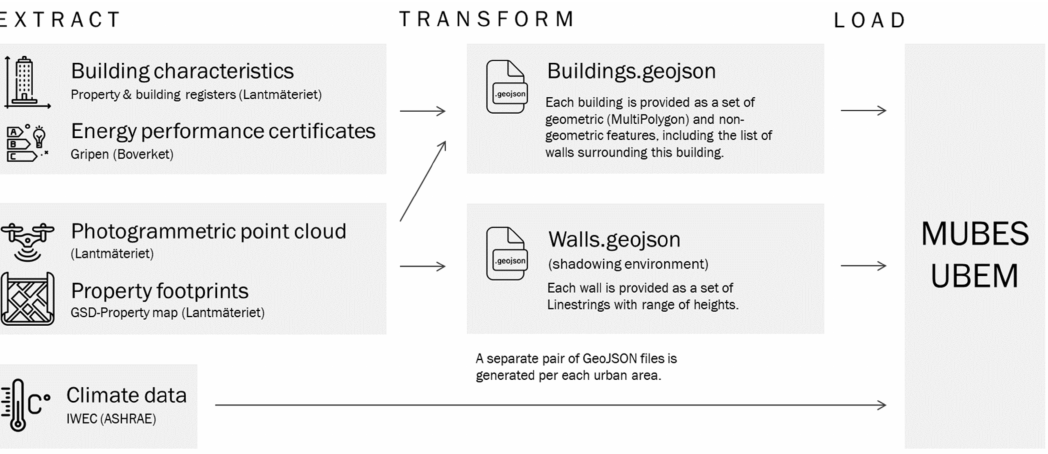
Figure 2. Data integration—primary data sources and derived data products loaded into the